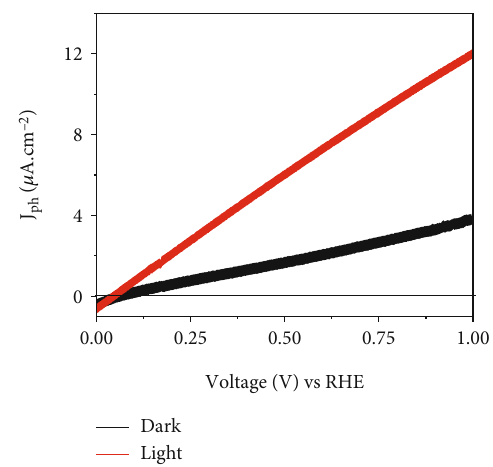
Figure 5: The produced current density under dark and light for the PANI/Ag O-Ag composite II at 25 ° 2